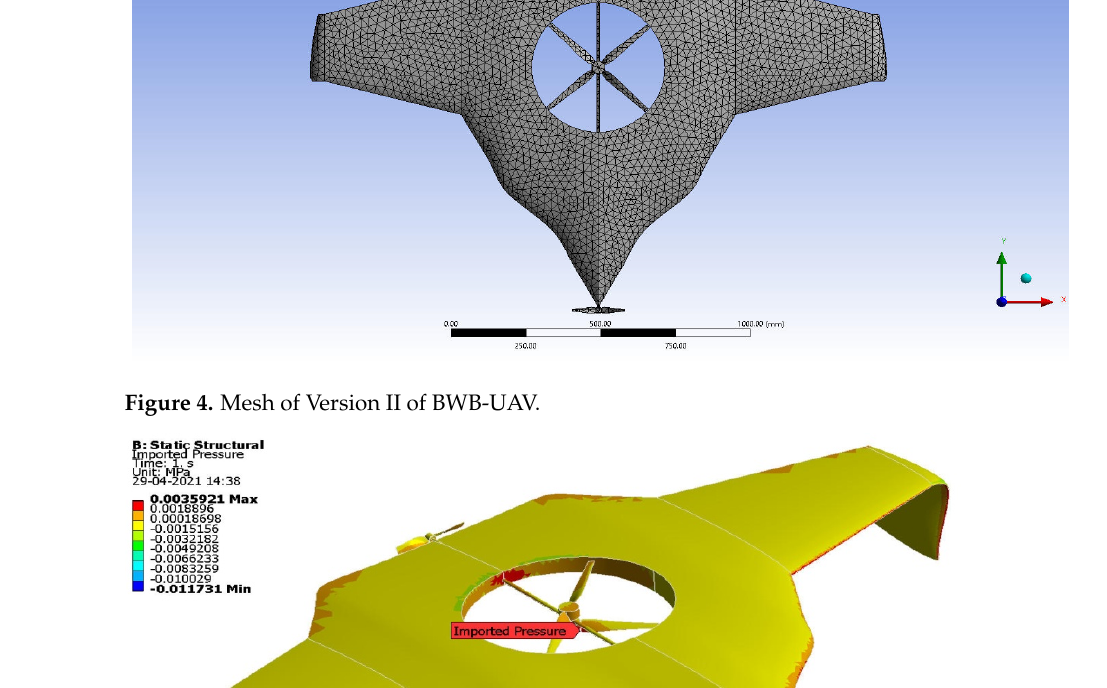
Figure 5. Aerodynamic loads imported for Version II.